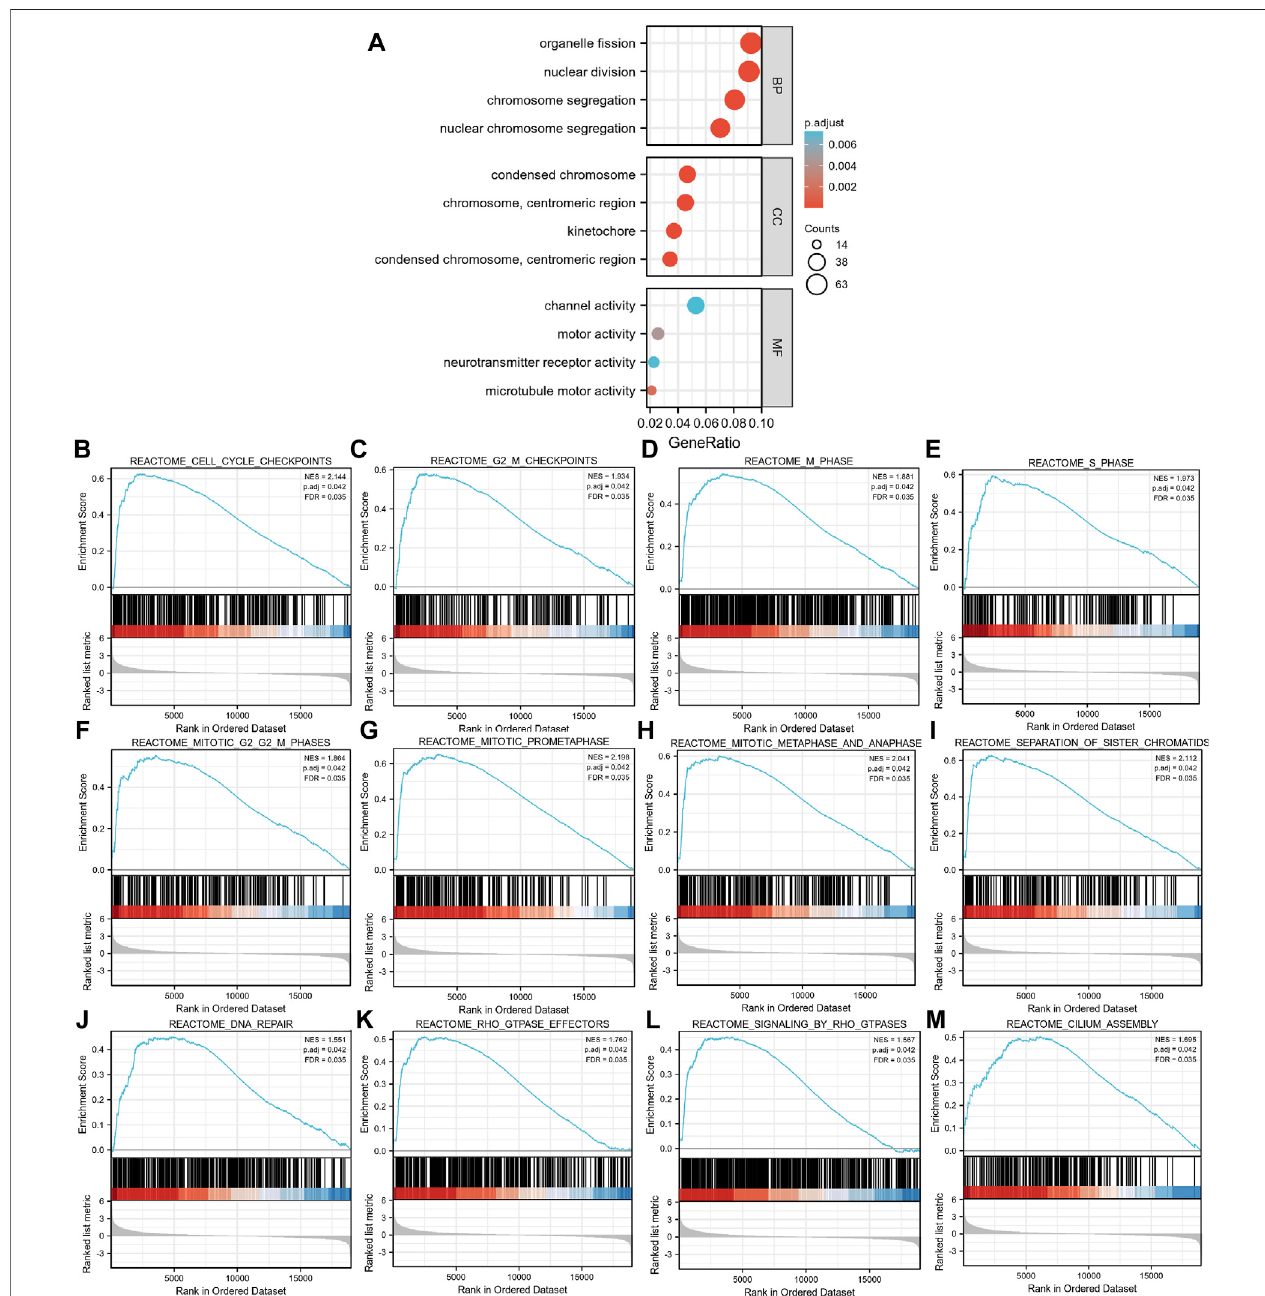
FIGURE 2 | Functional enrichment analysis of the differentially expressed genes (DEGs) based on the EXO1 expression levels in HCC. (A) GO enrichment analysis of the EXO1-associated DEGs show the enriched biological functions (BP), cellular components (CC), and molecular functions (MF). (B – M) Gene Set Enrichment Analysis(GSEA)ofthealteredsignalingpathwaysintheHCCtissuesbasedontheEXO1-associatedDEGsbetweenthehigh-andlow-EXO1expressiongroupsinHCC.